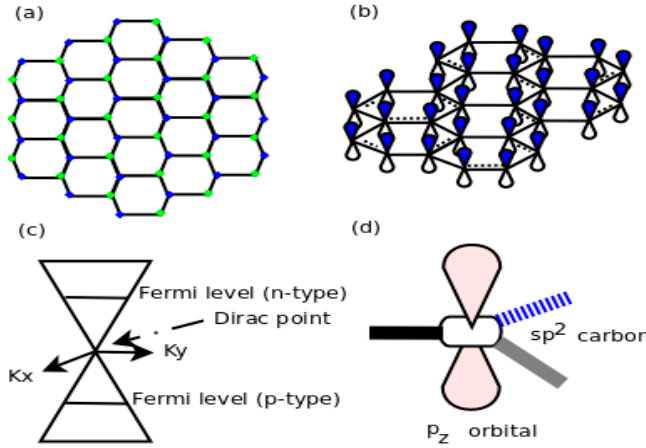
Figure 3. ( a )Two-dimensional (2D) graphene layer ( b ) 2D graphene layer with p z orbital ( c ) Fermi level shift from Dirac cone after graphene–metal hybrid formation ( d ) sp 2 hybridized carbon atom.